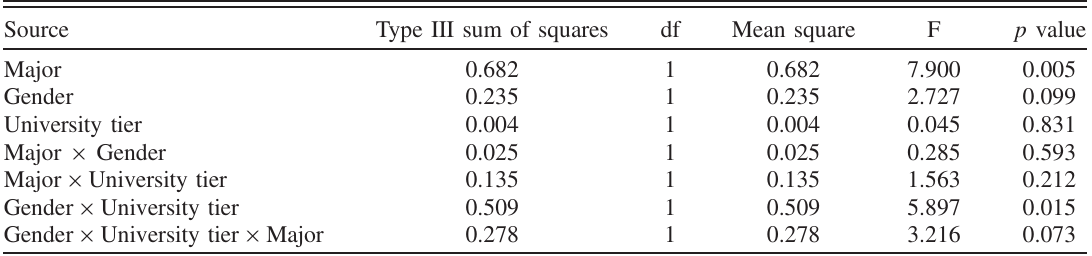
TABLE III. Three-way ANOVA for overall epistemological beliefs towards physics learning.